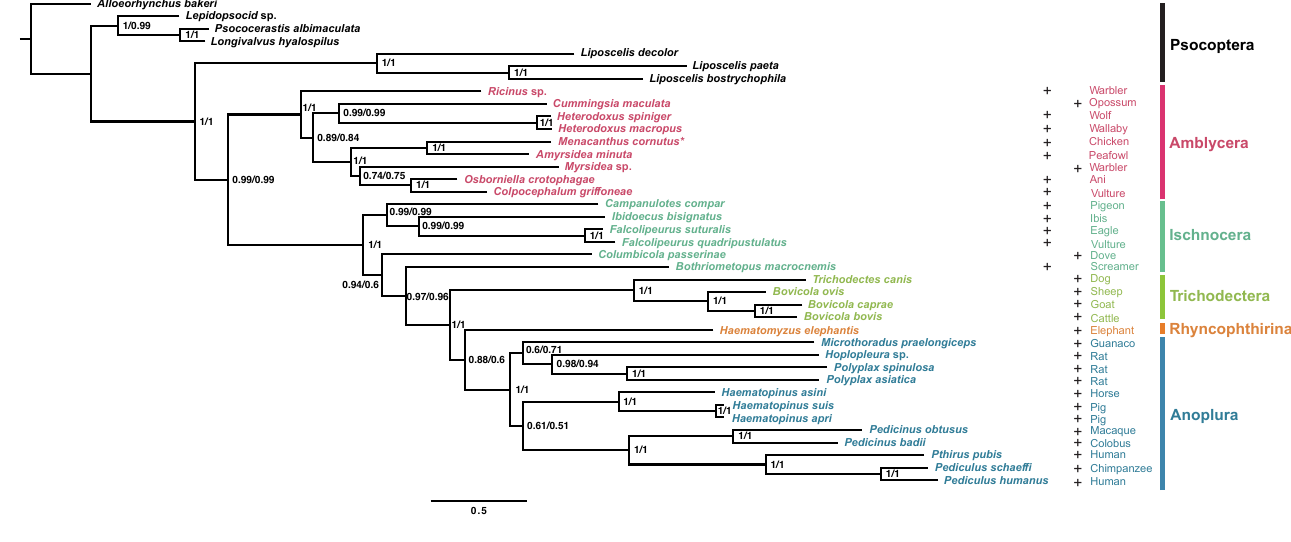
Figure 2. Phylogenetic trees of Phthiraptera inferred from the PCGRNA and PCG12RNA datasets using PhyloBayes under the site-heterogeneous mixture CAT + GTR model. Supports at nodes (from left to right) are Bayesian posterior probabilities (BPPs) for PCGRNA and PCG12RNA. The mitochondrial genome sequence of M. cornutus is highlighted with an asterisk (*). The genome architecture (typical or fragmented) is indicated by a plus sign (+). The bird and mammal hosts are indicated after the names of the parasitic